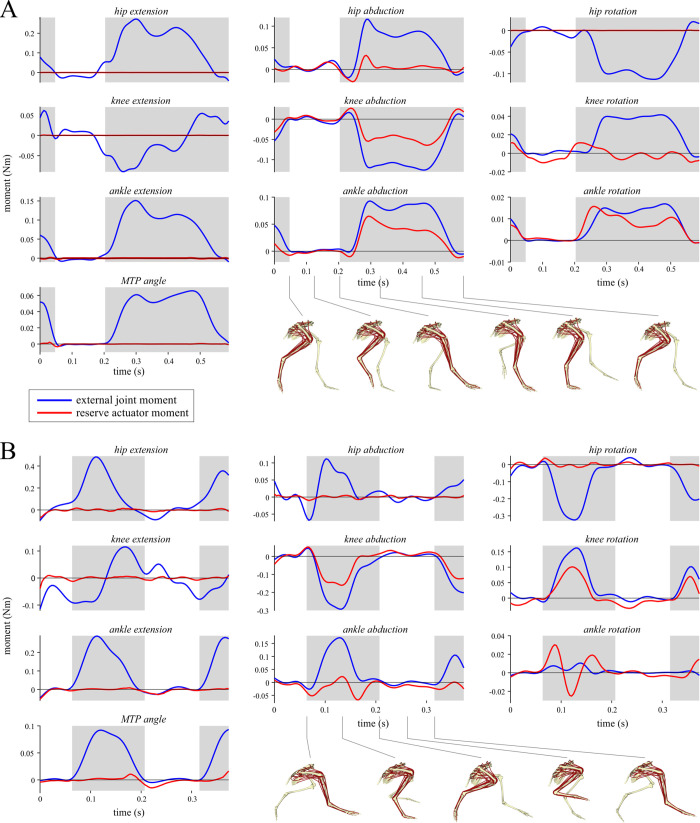
Reserve actuator contributions to external joint moments.This is shown for walking (A) and running (B) trials. Grey regions denote the stance phase, white regions denote the swing phase. Note the strong contributions to external joint moment made by reserves acting about the abduction–adduction and long-axis rotation DOFs of the knee and ankle joints. Also illustrated are the kinematics of the left hindlimb (reversed for visualization) at various parts of the stride cycle.